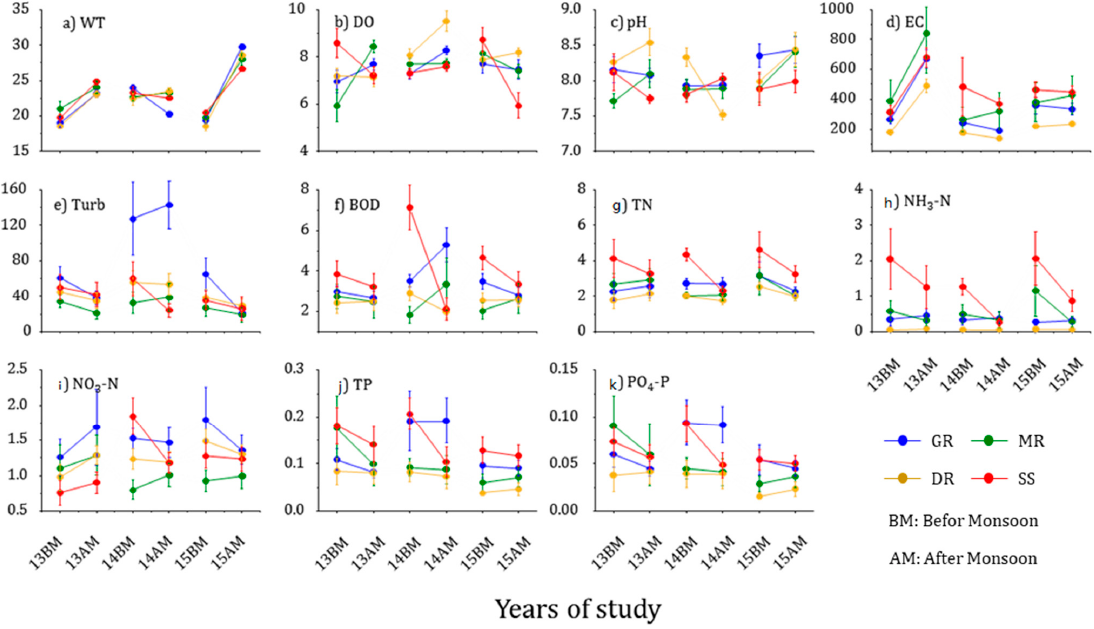
Figure 6. Temporal variability of the physical-chemical variables in the four central western major streams of the Korean Peninsula from 2013 to 2015 (BM: before monsoon, AM: after the monsoon, GR: Geumgang River, MR: Mangyeonggang River, DR: Dongjingang River, SS: Sapgyocheon stream). WT: water temperature (°C), DO: dissolve oxygen (mg/L), BOD: biochemical oxygen de-